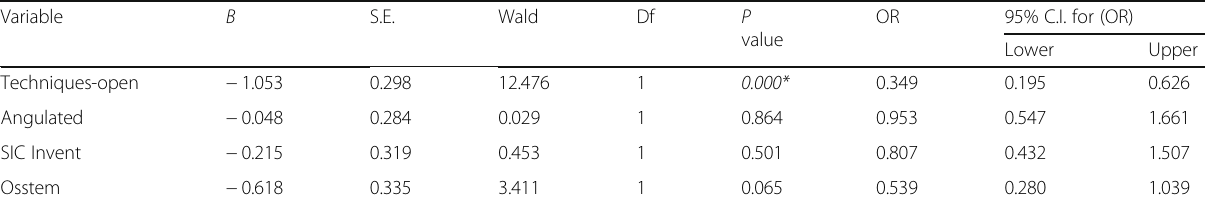
Table 5 Logistic regression estimates test Variable